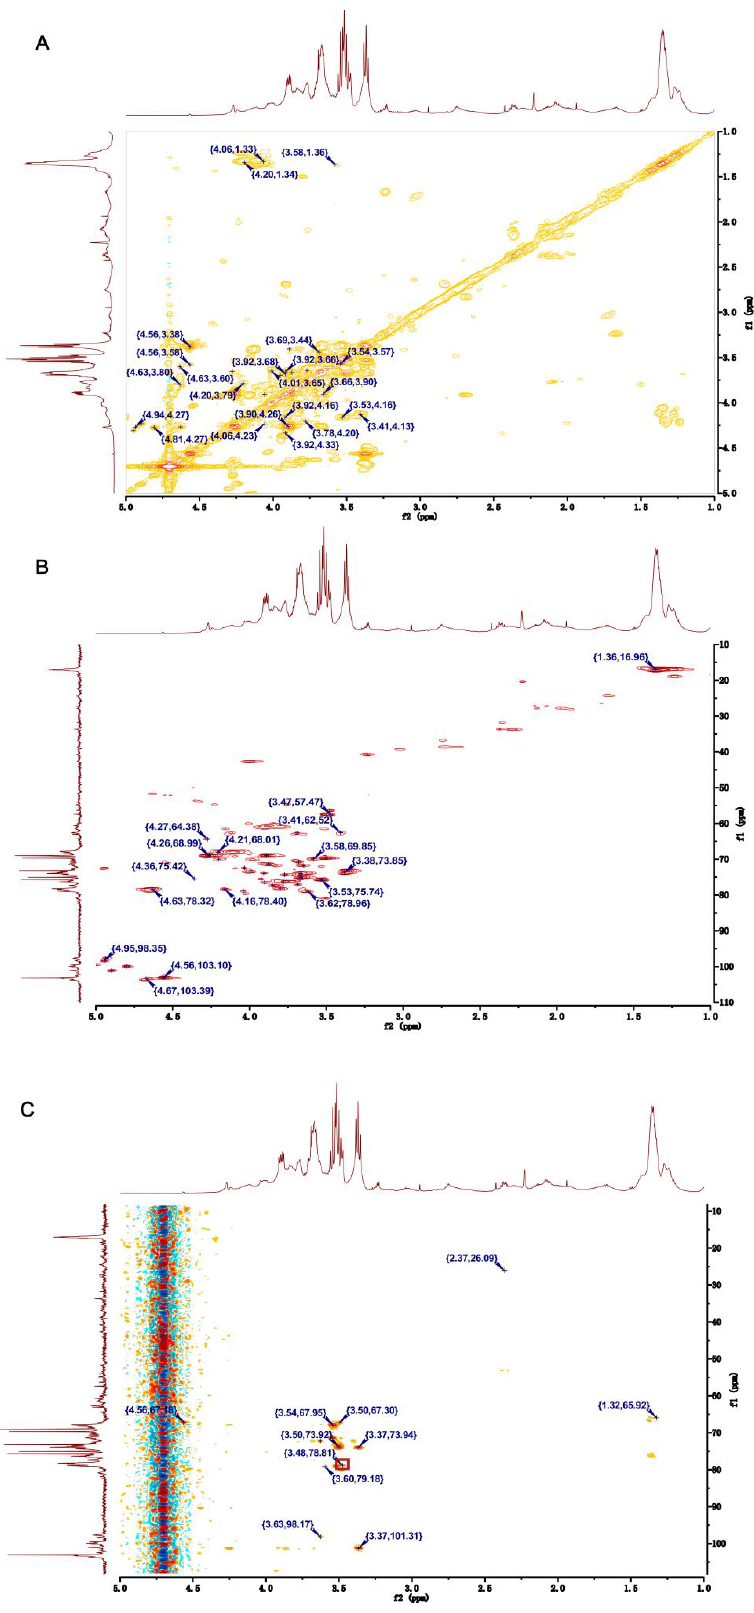
Figure 3. Two-dimensional NMR of U. ( A ) COSY NMR of U. ( B ) HSQC NMR of U. ( C ) HMBC NMR of U.